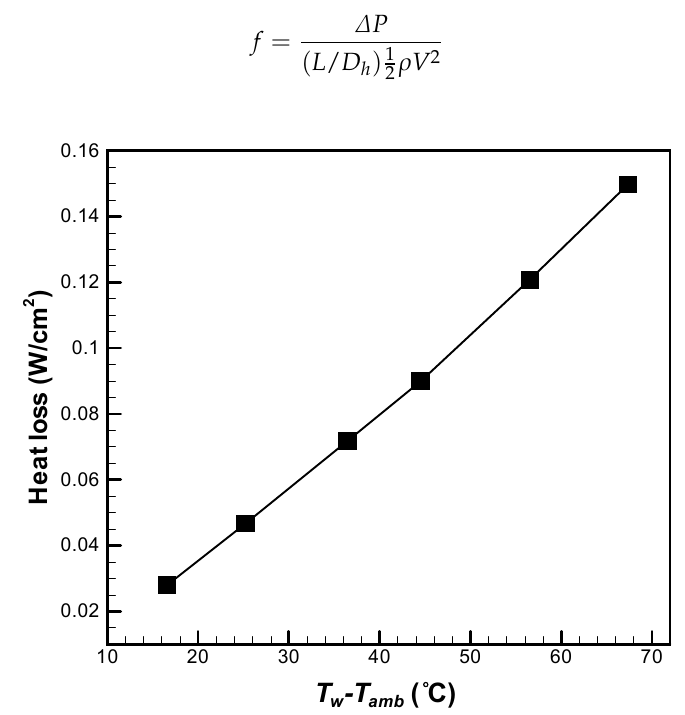
Figure 4. Heat loss with respect to the temperature difference.